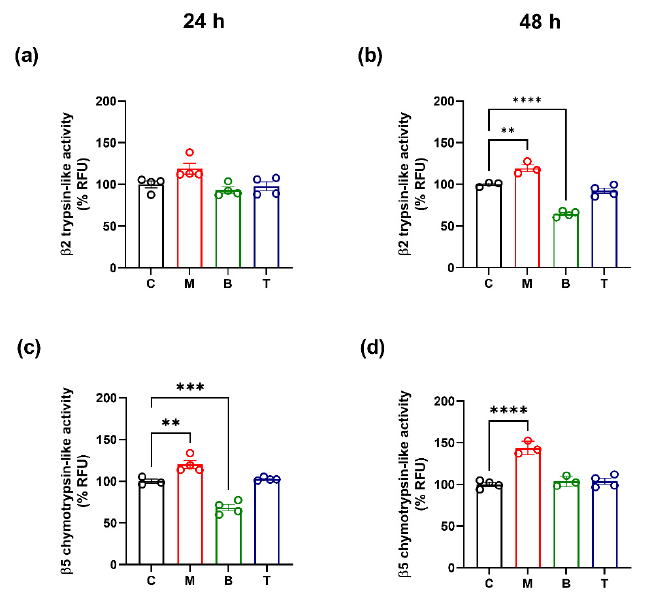
Figure 4. β 2 trypsin-like ( a , b ) and β 5 chemotrypsin-like ( c , d ) activities after treatment with 10 µ M morphine (M), 0.25 µ M buprenorphine (B) or 10 µ M tapentadol (T) in SH-SY5Y cells at 24 h ( a , c ) and 48 h ( b , d ). Data, reported as the mean ± SEM of three/four biological replicates for each treatment, are expressed as the percentage of relative fluorescence (RFU) compared to control (C) and analyzed by one-way ANOVA followed by Dunnett’s multiple comparisons test (** p < 0.01; *** p < 0.001 vs. control; **** p < 0.0001 vs. control). Gene expression results showed that the investigated drugs also affect β 2 and β 5 subunit biosynthesis. In particular, morphine induced a significant down-regulation of β 2 subunit gene expression both at 24 and 48 h ( p < 0.01; p < 0.001 vs. control) (Figure 5a,b), while it caused an increase in β 5 mRNA levels after 48 h ( p < 0.05 vs. control) (Figure 5d). As regards the impact of buprenorphine and tapentadol on β subunits gene expression, data showed that these molecules decreased β 2 and β 5 mRNA levels after 24 h ( p < 0.01; p < 0.001 vs. control) (Figure 5a,c) and that β 5 subunit down-regulation was maintained at 48 h only after tapentadol treatment ( p < 0.01 vs. control) (Figure 5d).